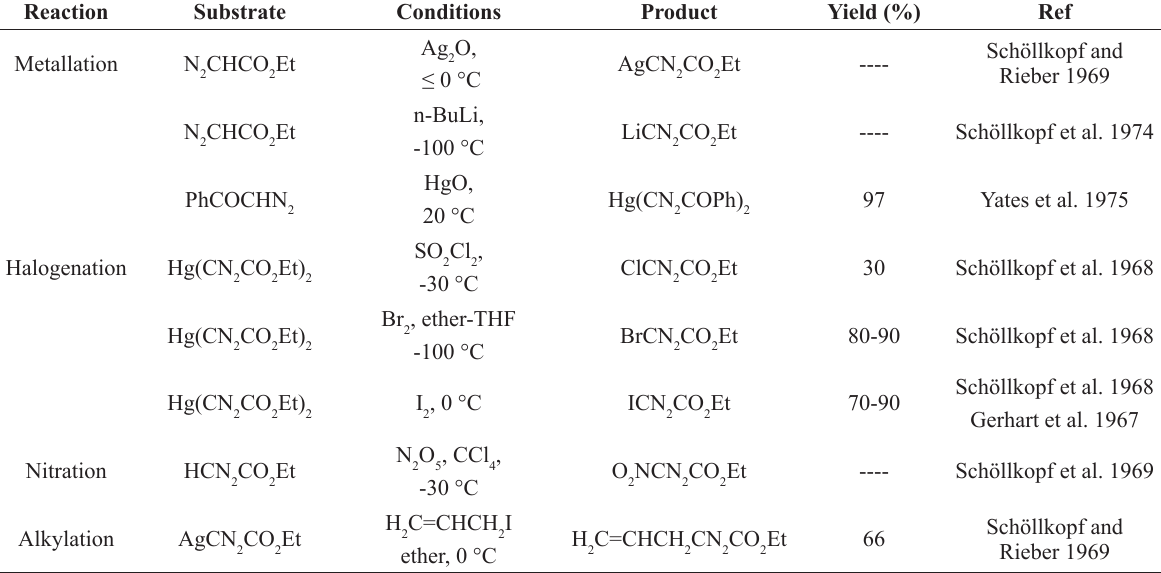
Substitution reaction of terminal diazocarbonyl